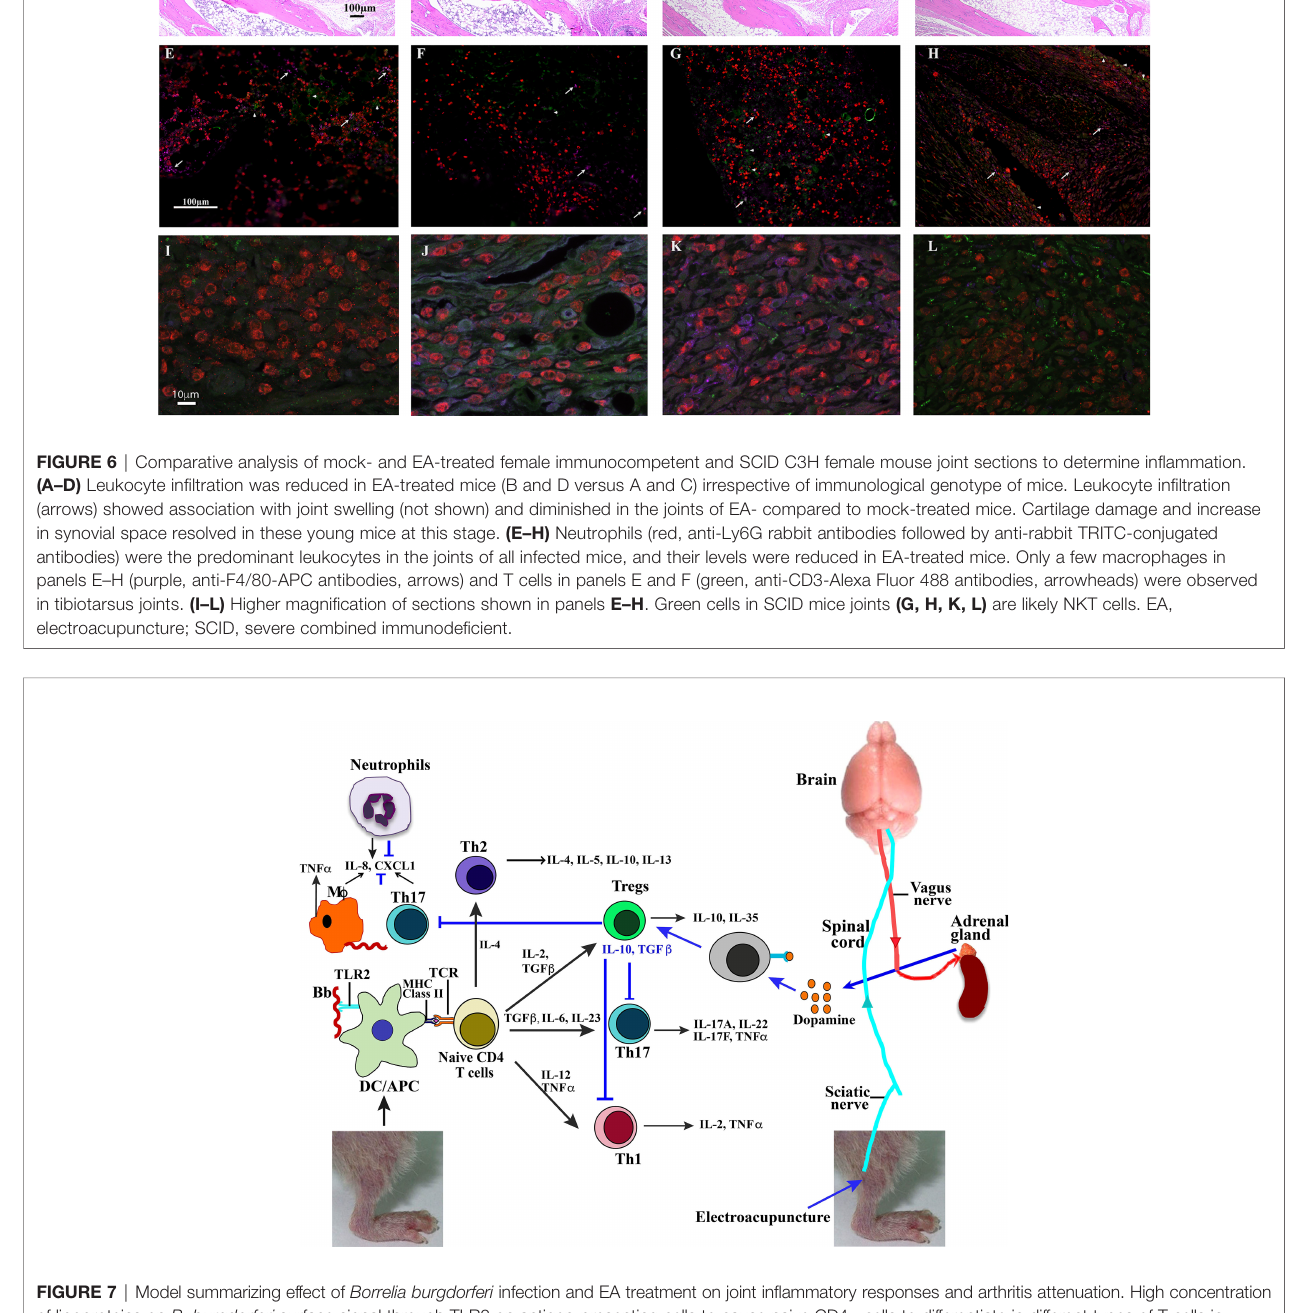
FIGURE 7 | Model summarizing effect of Borrelia burgdorferi infection and EA treatment on joint in fl ammatory responses and arthritis attenuation. High concentration of lipoproteins on B. burgdorferi surface signal through TLR2 on antigen-presenting cells to cause naive CD4+ cells to differentiate in different types of T cells in response to various combinations of cytokines produced. These Treg, Th17, or Th1 cells then produce listed cytokines (marked by black arrows). Neuromodulation of brain through sciatic nerve electrostimulation by EA results in signaling of adrenal glands through vagus nerve to produce dopamine (marked by blue arrows). Binding of dopamine neurotransmitter to receptor present on lymphocytes results in activation of Tregs, which then suppress Th1- and Th17-mediated in fl ammatory Lyme arthritis. EA, electroacupuncture.